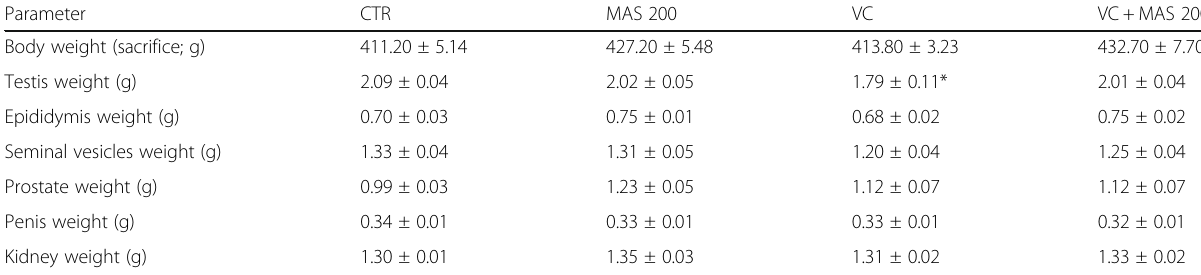
Table 1 Effect of MAS 200 on body weight and reproductive organ weight in varicocele-induced male SD rats